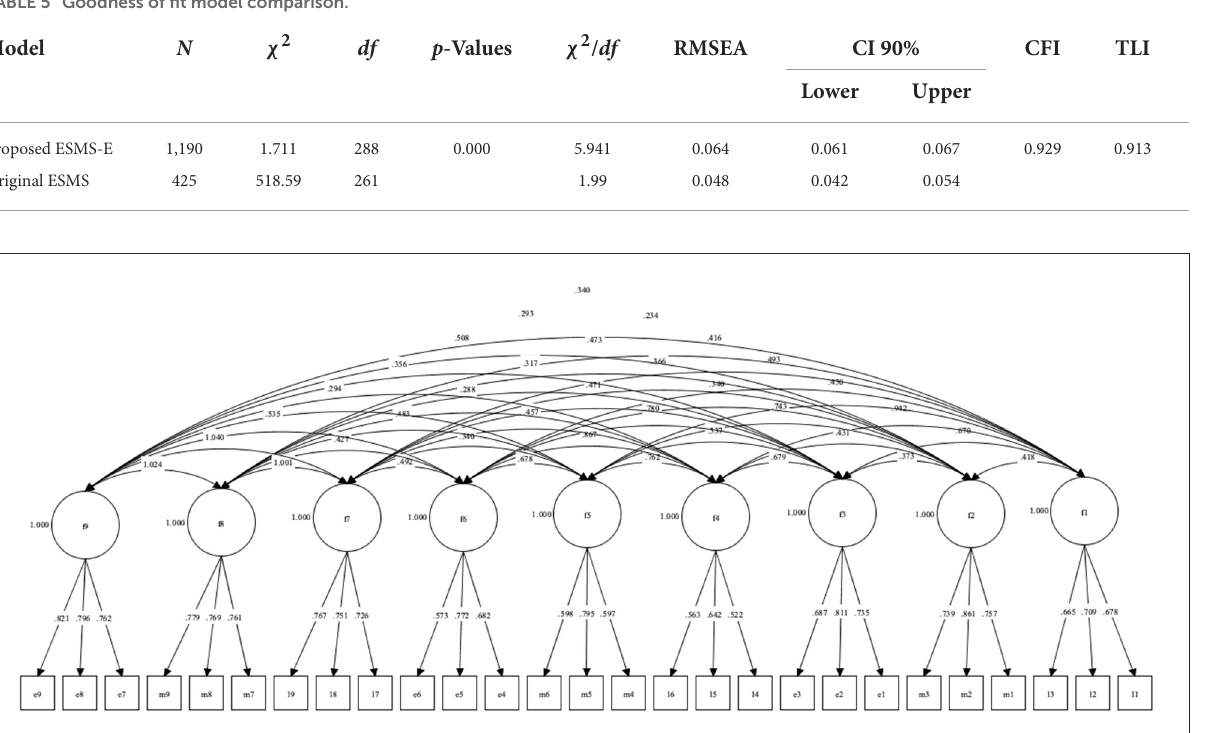
FIGURE3 Proposed model for the ESMS-E with weights and correlations between